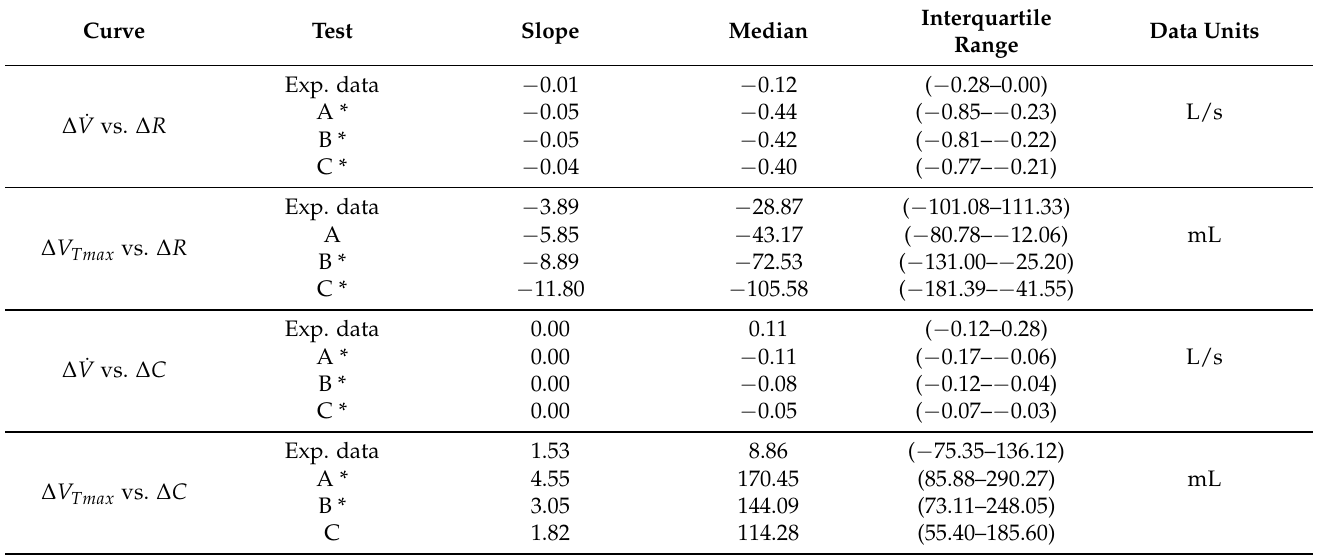
Table 3. Median, interquartile range, and slope for each dataset in the population analysis for the “Anatomy and Physiology”